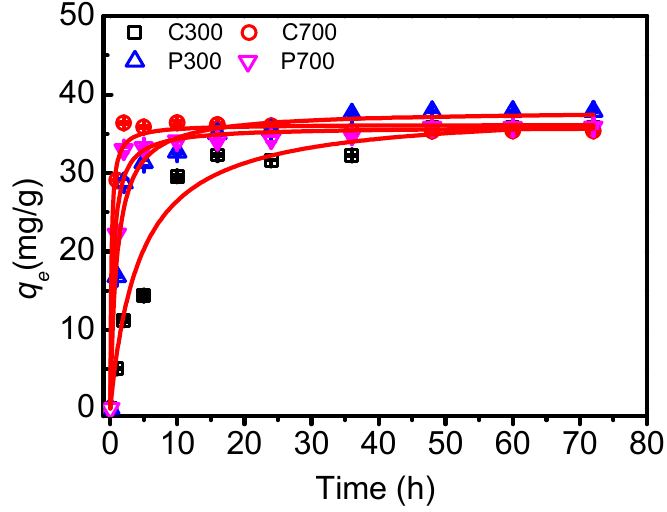
Figure 3. Adsorption dynamics for dodecylbenzene sulfonic acid (DBSA) on crop straw and poplar leaf biochars. The bars are the standard errors. The lines represent pseudo-second order kinetic fitting.